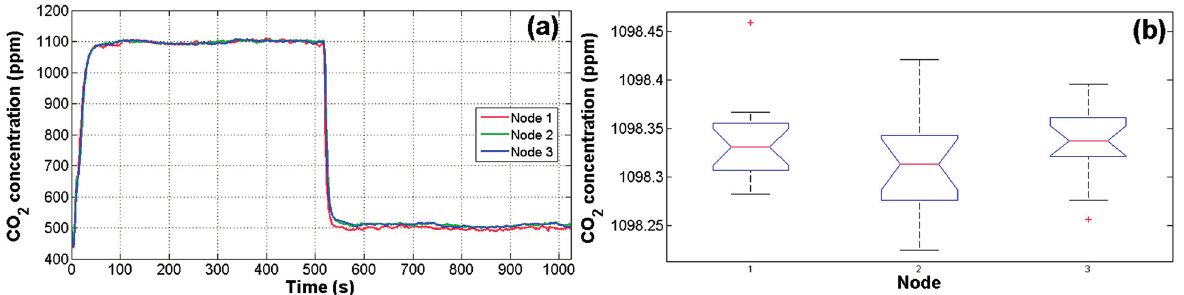
Figure 5. Validation test of IRGA CO 2 sensors. ( a ) 1 cycle monitoring with an 1100 ppm CO 2 reference; ( b ) Analysis of variance boxplot results.